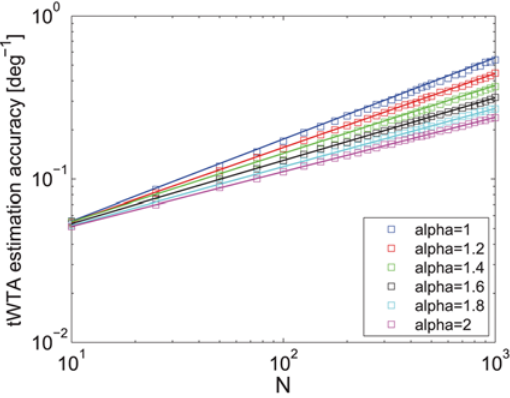
Figure 7. Estimation accuracy of the tWTA readout in a hypercolumn model. The accuracy of the tWTA readout, in terms of one over the squared estimation error of estimating h ~ 0 , is plotted as a function of the population size, in an IHPP hypercolumn population model, equation(30). The latency tuning was modeled by t D h ð Þ ~ D h j j a ms (where D h is measured in radian) with a ~ 1,1 : 2, ... ,2 from top to bottom. Accuracy was measured by averaging the squared estimation error over 10,000 trials of simulating the neuronal stochastic response (squares). The solid lines show the analytical fit using equation